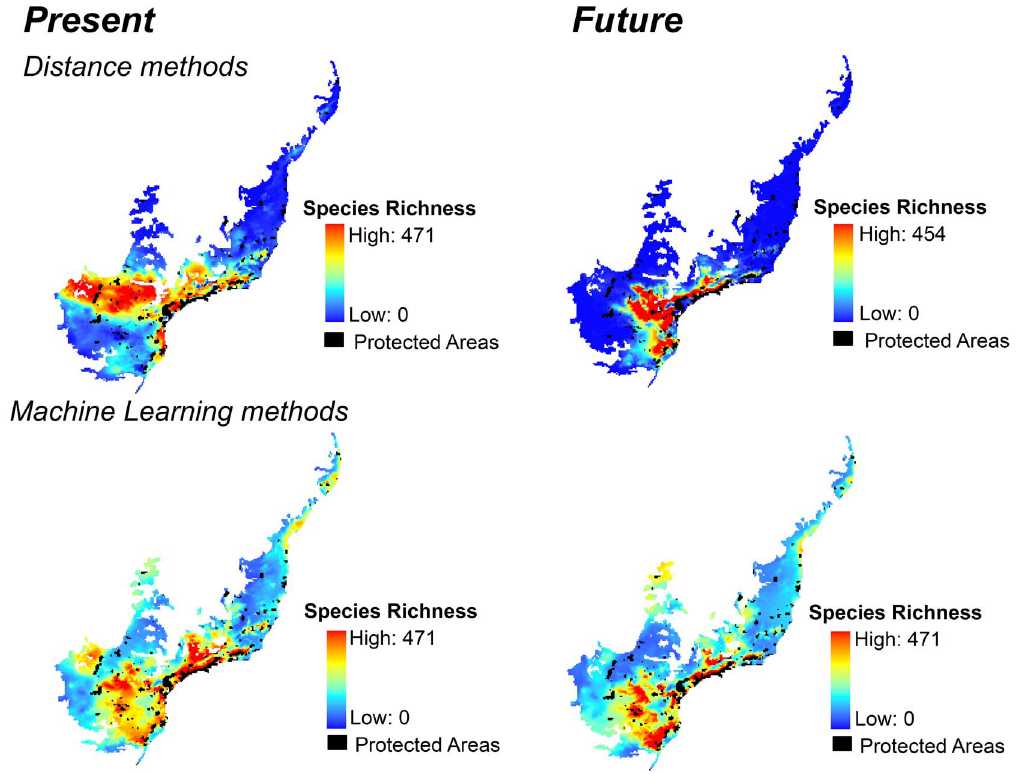
Figure 3. Consensus maps for tiger moth species richness in the Atlantic Forest Biodiversity Hotspot, Brazil. Maps of modeled tiger moth species richness based on consensus projections of 507 species predicted to occur in the Atlantic Forest Biodiversity Hotspot, Brazil, for current time (1950–2000) and 2080 (2051–2080) according to two different types of modeling methods and climate models. Models from distance and machine-learning methods were combined through an ensemble of forecasts to generate these consensus